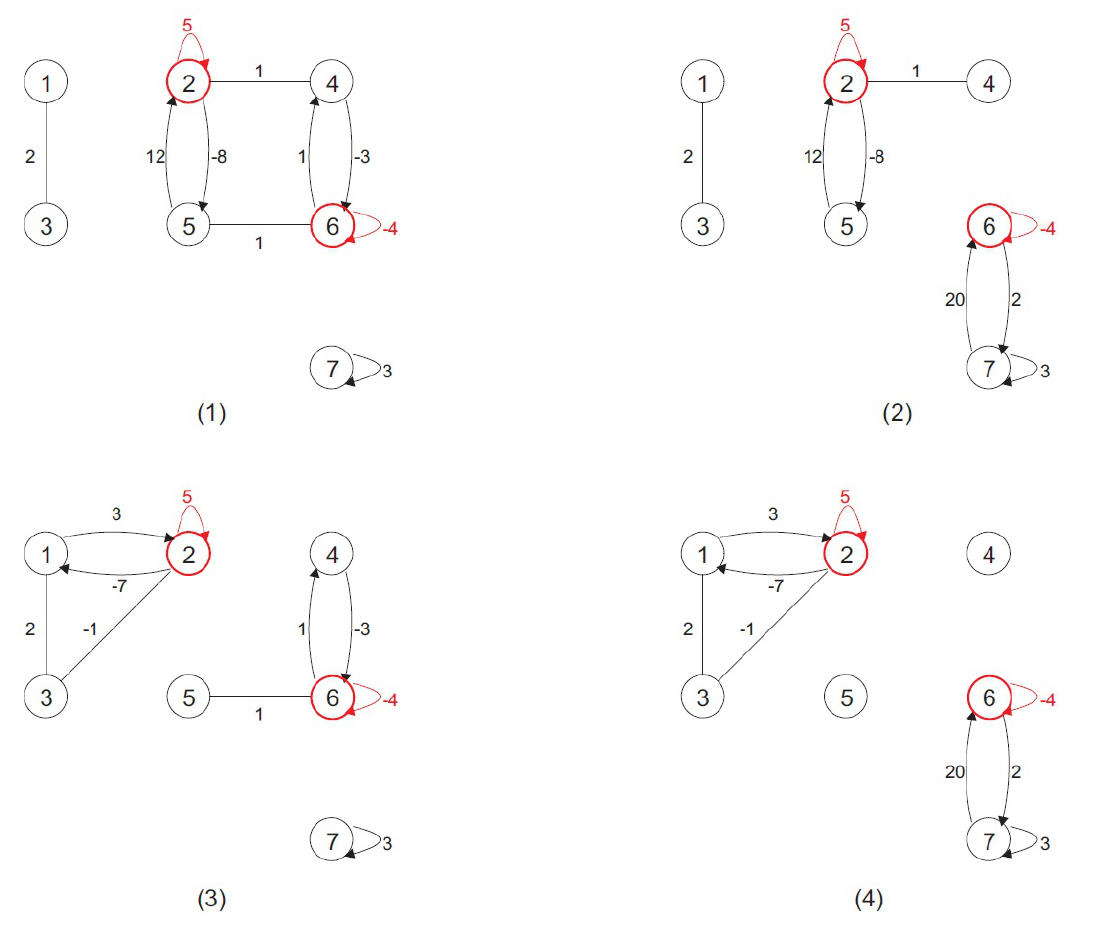
Figure 4: B -partitions of the digraph of matrix M